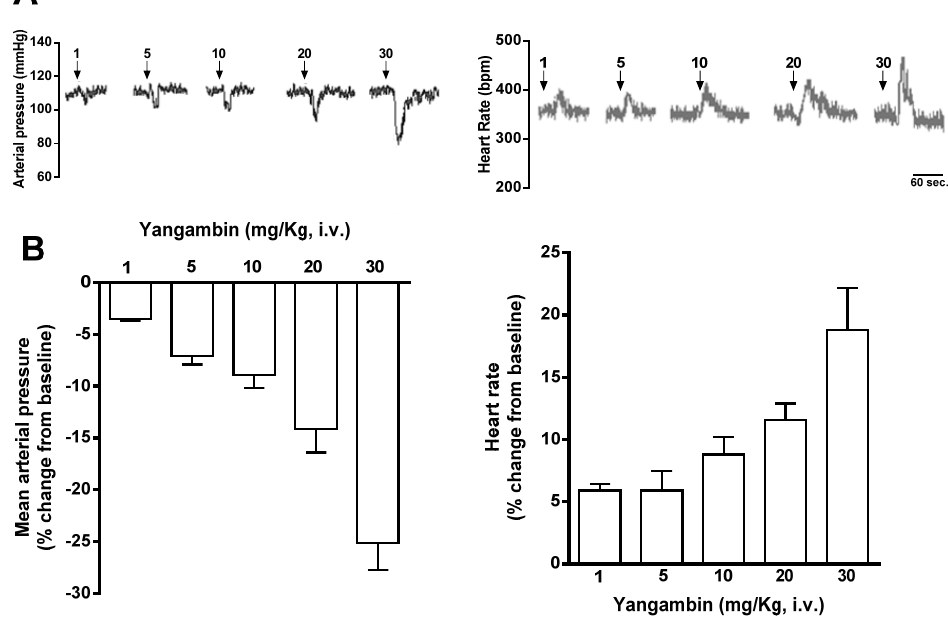
Figure 2. Hypotensive response to yangambin in non-anesthetized rats. ( A ) Representative tracing showing the effects of yangambin on mean arterial pressure and heart rate. The arrows indicate the point at which the doses of yangambin (1, 5, 10, 20, 30 mg/kg) were administered (i.v.). ( B ) Bar graph showing the changes in mean arterial pressure, and heart rate induced by the acute administration of yangambin (1, 5, 10, 20, 30 mg/kg bodyweight, randomly) in non-anesthetized rats. Values are mean ± S.E.M. ( n =